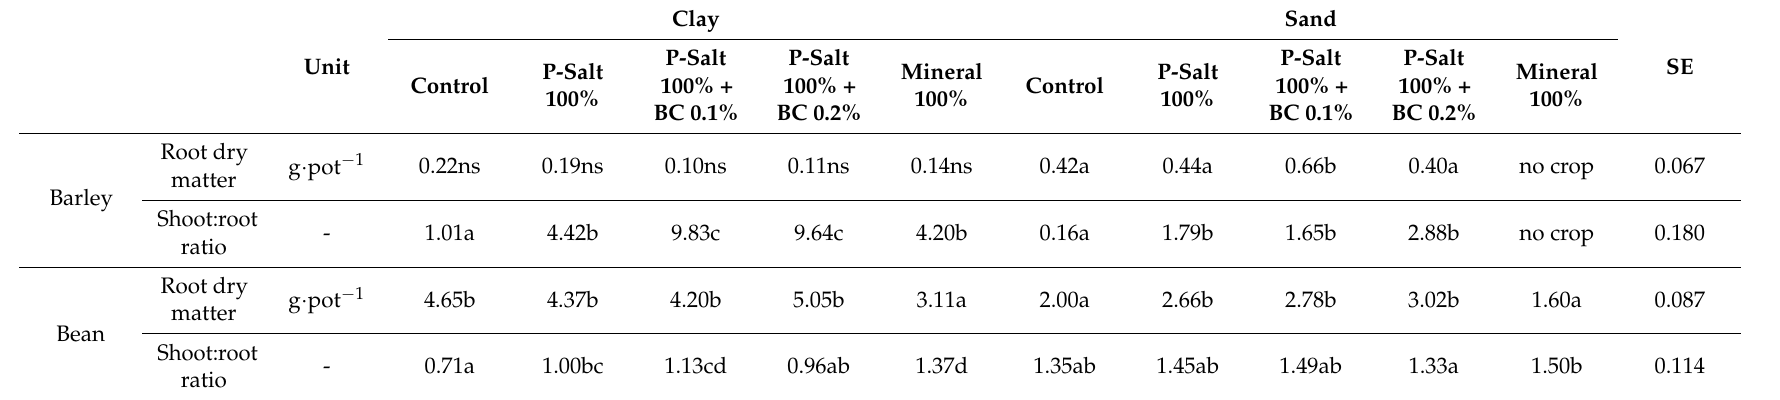
Table 9. Mean root dry matter and shoot:root ratio of barley and faba beans for fertilizer forms with/without biochar (BC) addition tested. Different letters in the table indicate statistically significant differences between treatments ( α = 0.05, n =